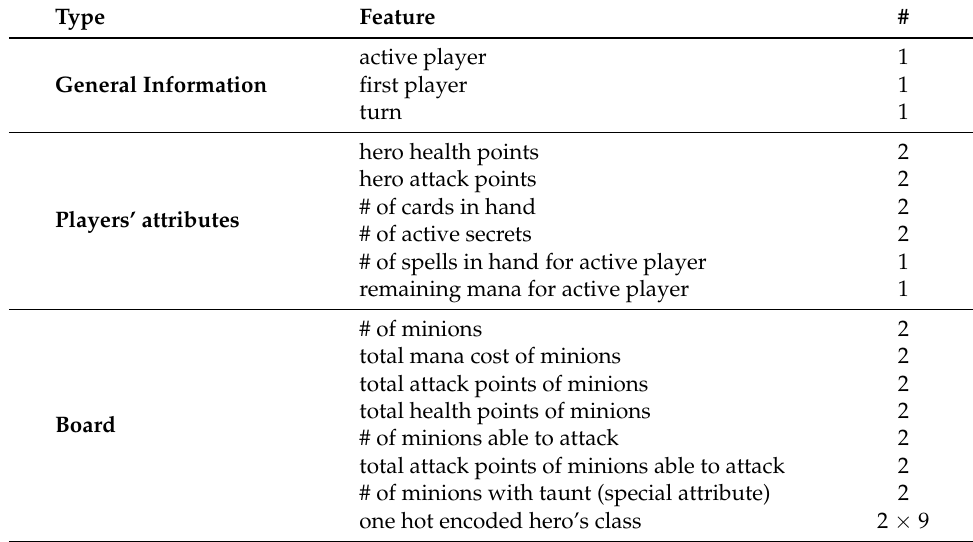
Table 1. Features selected for state representation in